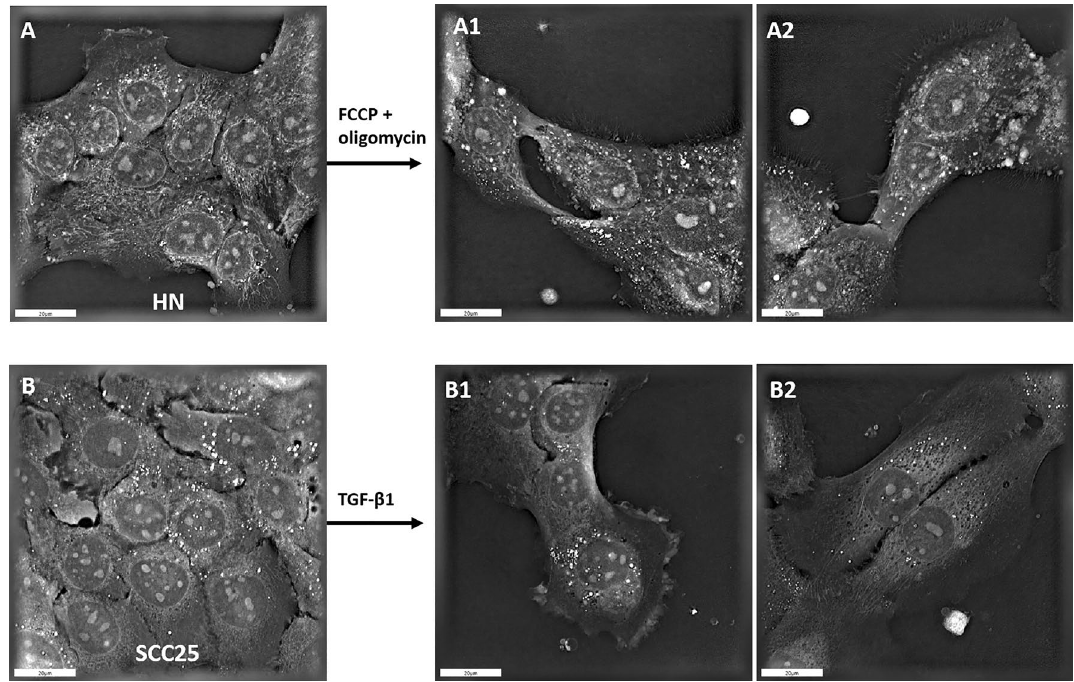
Figure 3. Holotomographic microscopy of HN cells ( A ) in response to FCCP/oligomycin addition (A1 + A2) and SCC25 cells ( B ) in response to TGF-ß1 (B1 + B2). Bars: 20 μm.